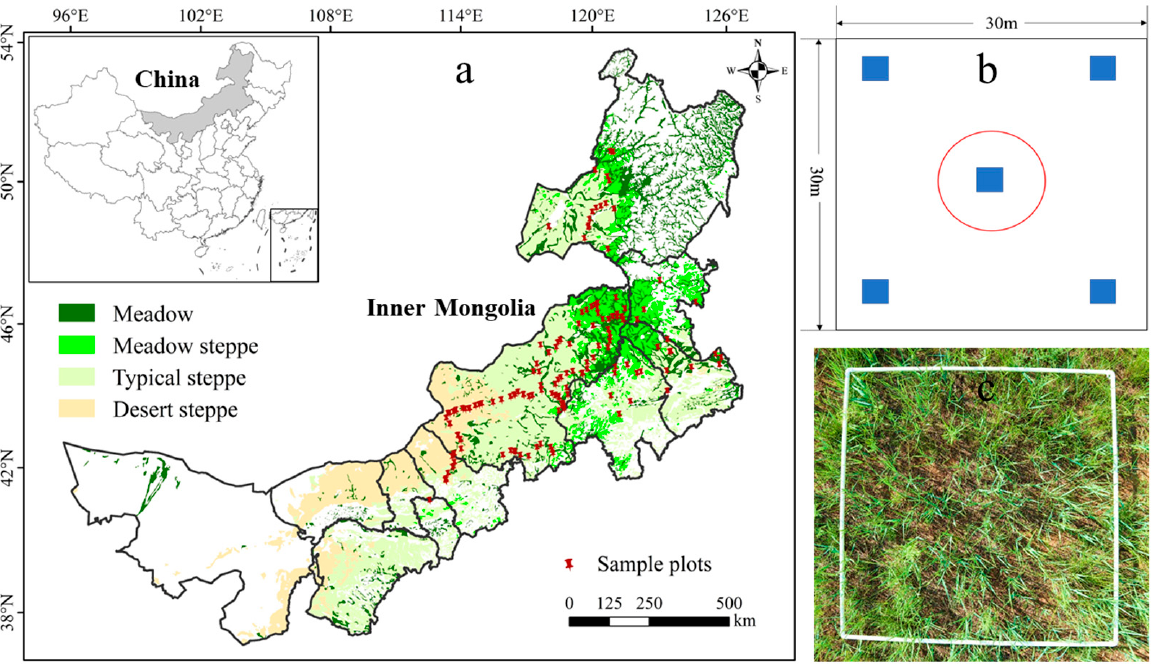
Figure 1. ( a ) Spatial distribution of grassland types and field sample plots in the study area; ( b ) the basic sample unit (30 m × 30 m); ( c ) the measurement of LAI for each subplot (1 m × 1 m).